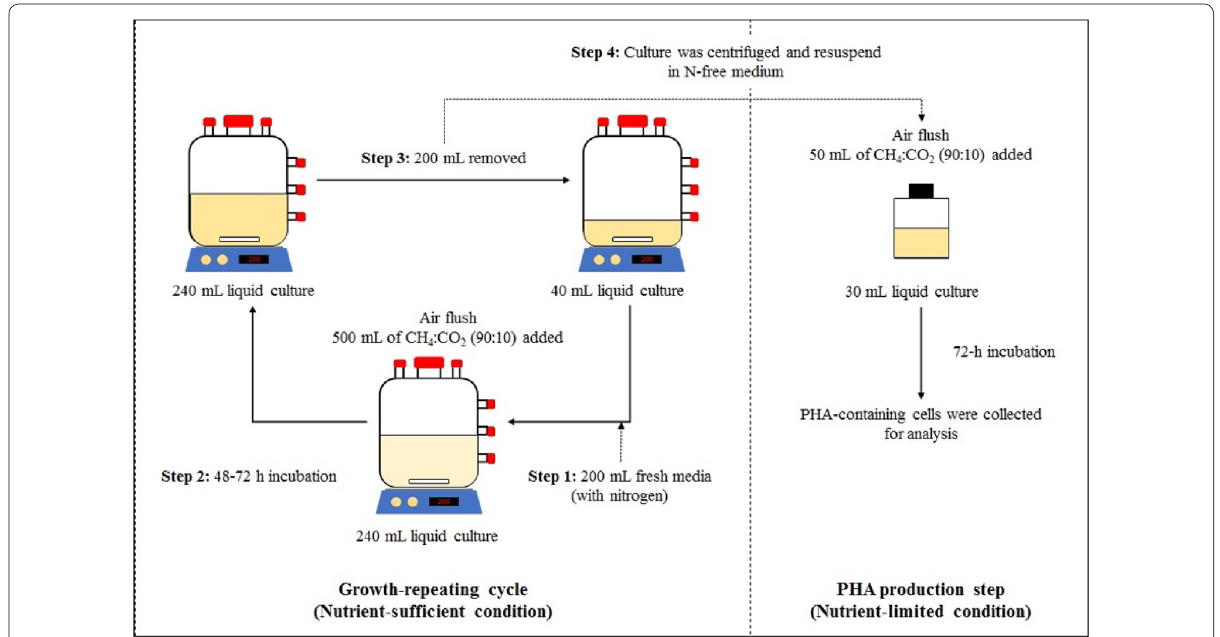
Fig. 1 Overall scheme of 2-L reactor operation and PHA production using methane as single carbon